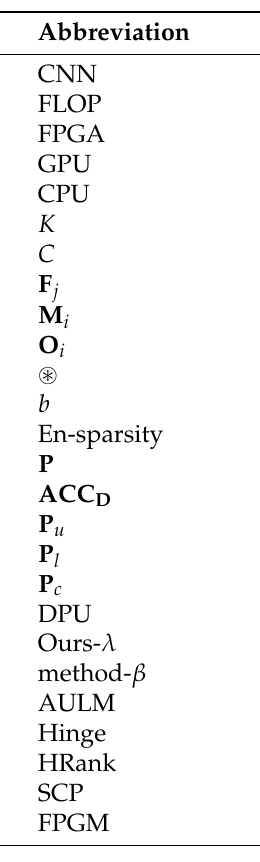
Table A1. List of abbreviations and